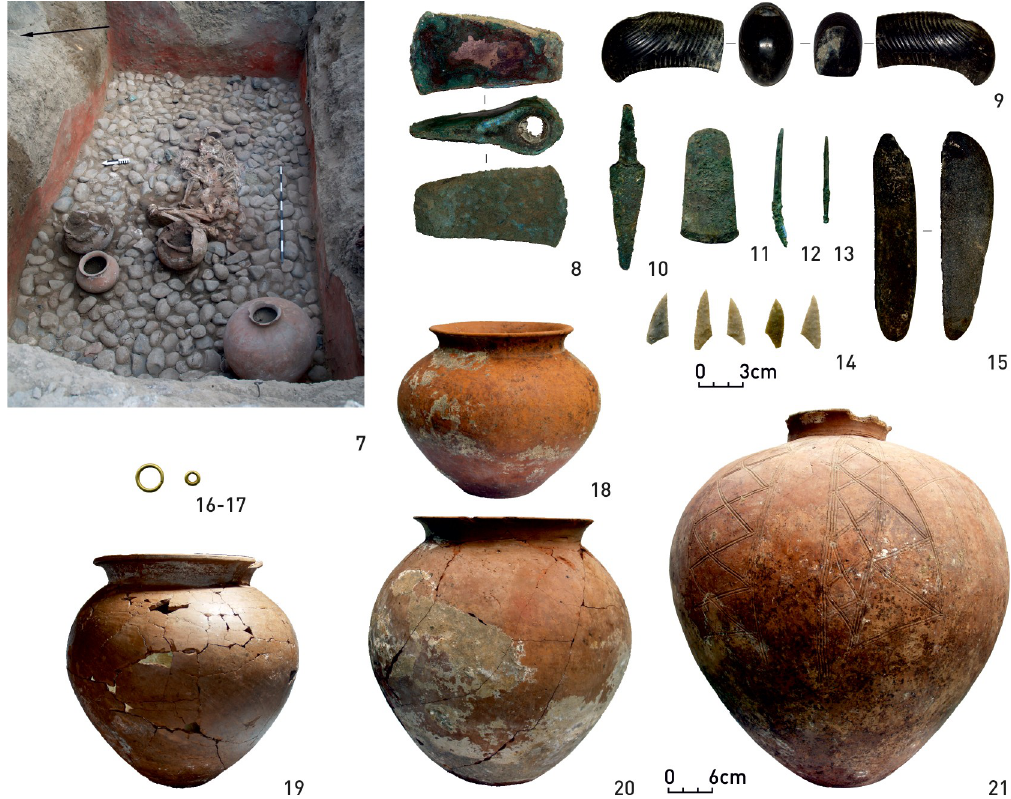
Fig 5. Marinskaya 3, Grave 18. Richly furnished inhumation of the Maykop culture with two golden earrings, a stone sceptre- axe, several bronze objects, four ceramic vessels and seven stone